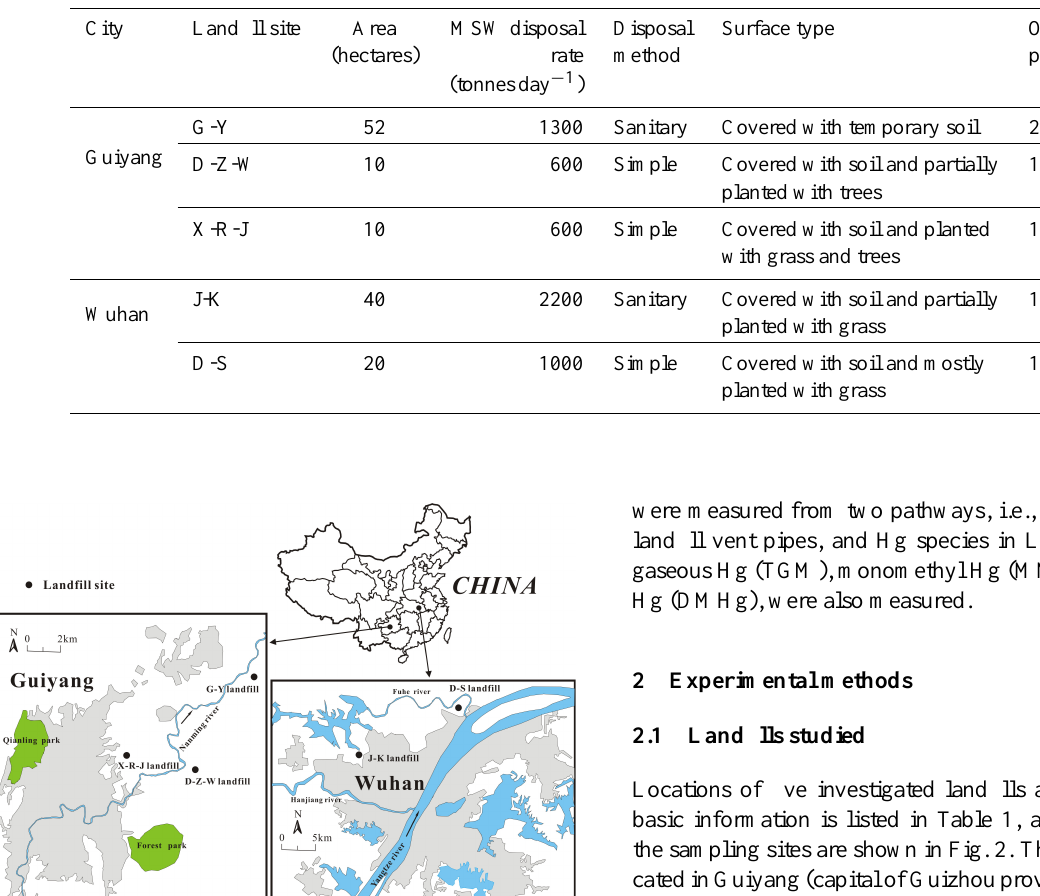
Table 1. Basic situation of the 5 studied MSW landfills.